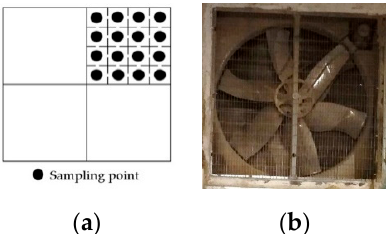
Figure 1. Diagram of sampling points ( a ) to measure air velocity and the real fan ( b ) installed in laying hen